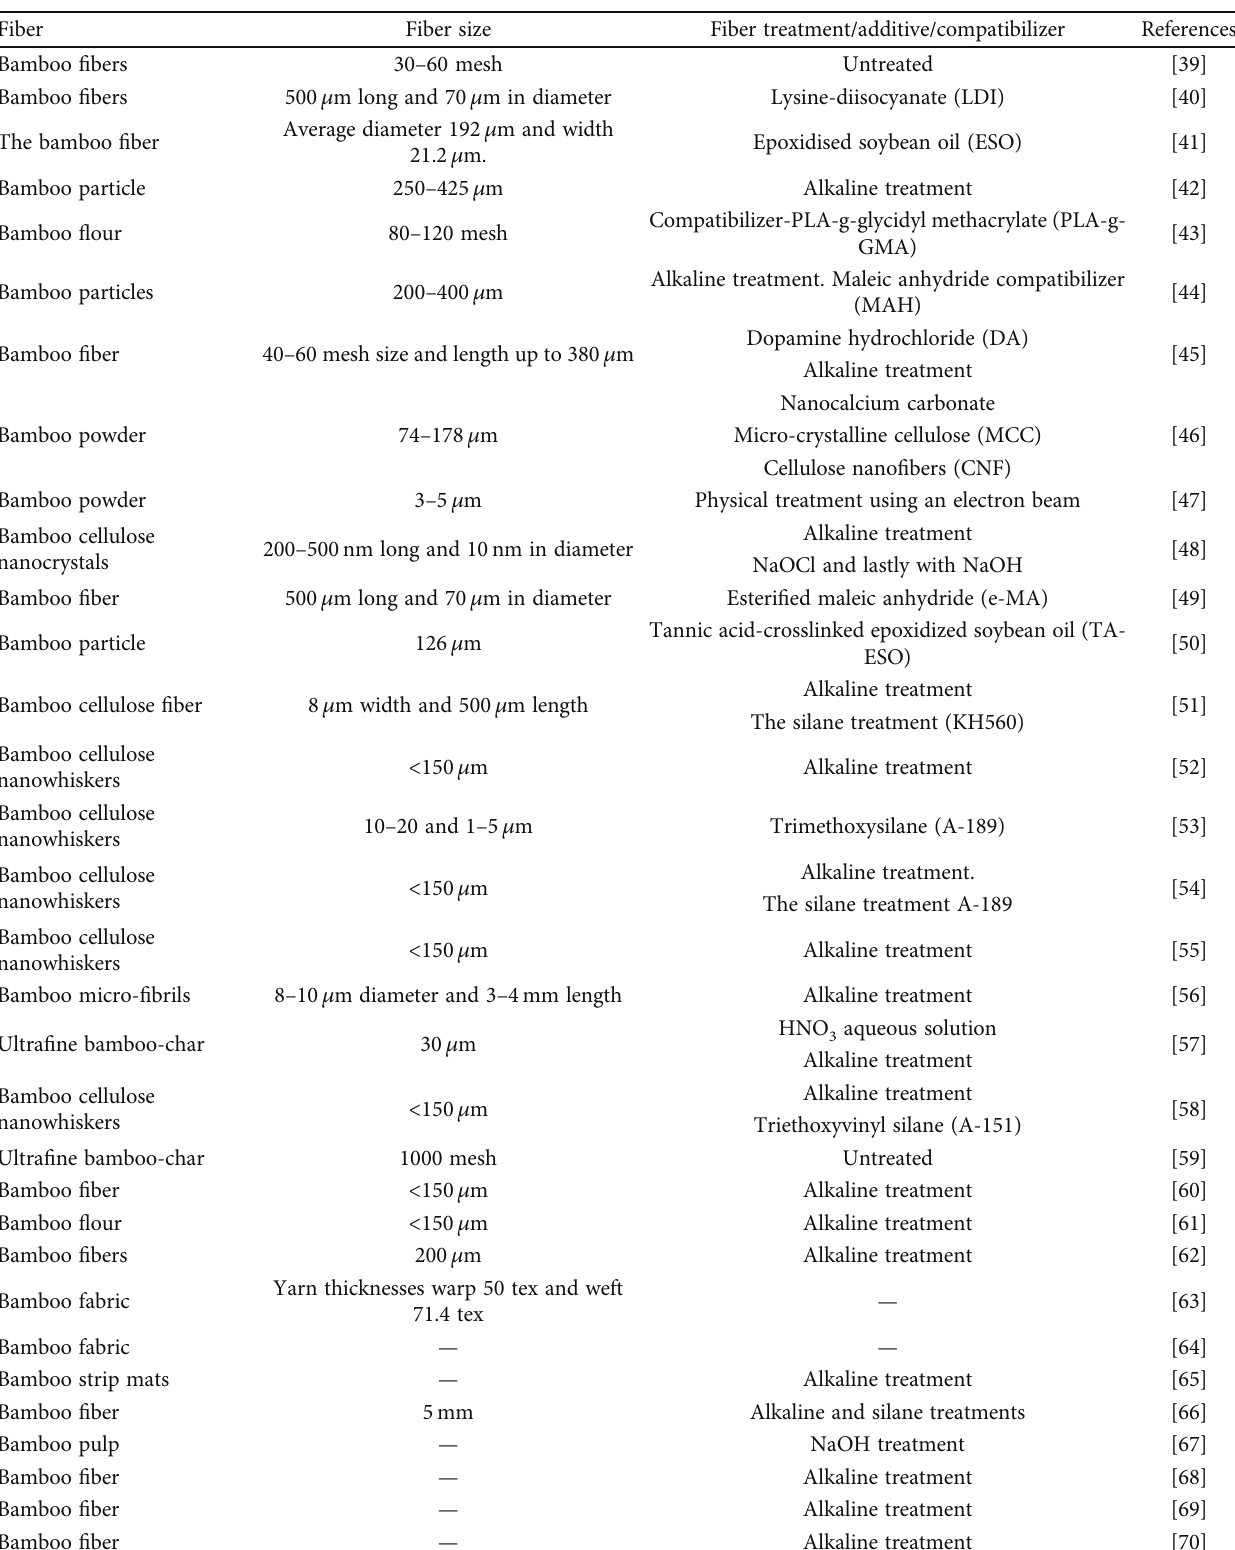
Table 3: Fiber treatment of bamboo fi ber